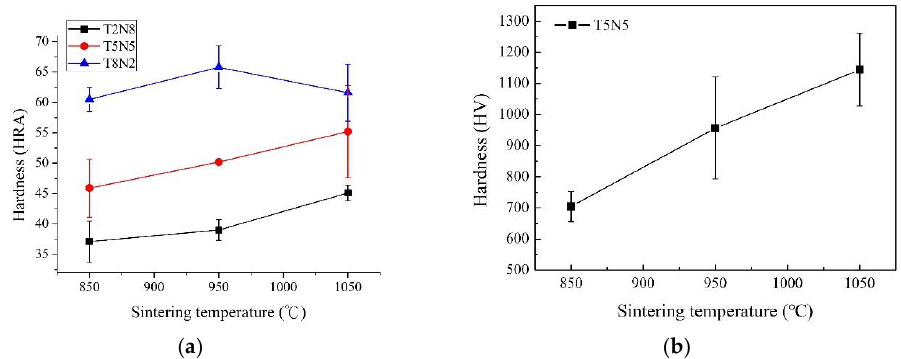
Figure 6. ( a ) Rockwell hardness of T2N8, T5N5 and T8N2 sintered at various temperatures. ( b ) Vickers microhardness of T2N8. Indentation is at the center of the titanium nitride particles sintered at various temperatures.